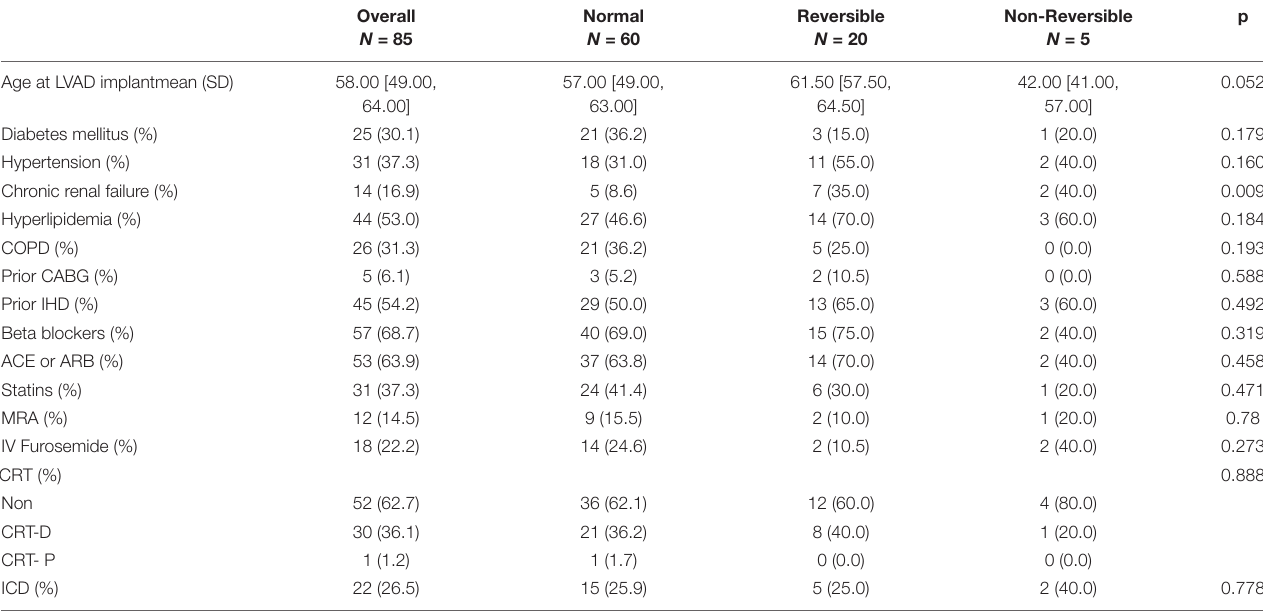
TABLE 1 | Baseline patient